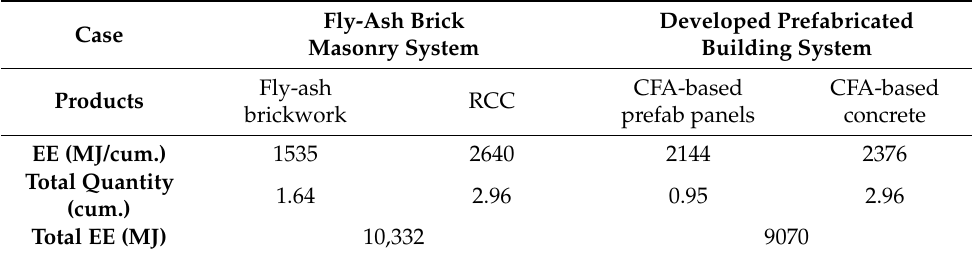
Table 4. Total EEs of conventional and proposed cases.